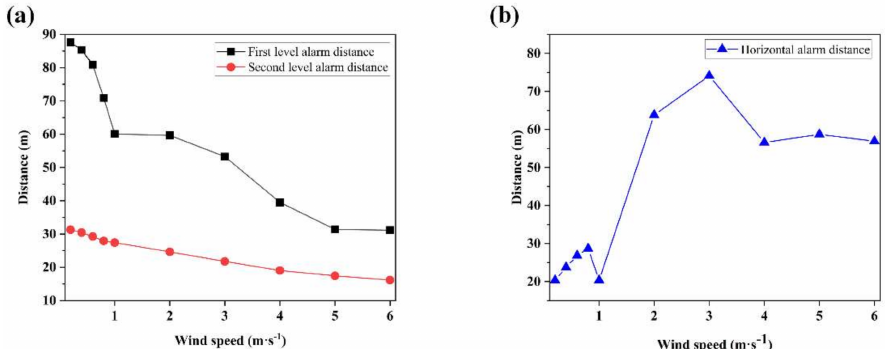
Figure 5. The relationship lines between the farthest alarm distance of combustible gas and wind speeds. ( a ) The relationship between the first-level and second-level alarm distance and the wind speed. ( b ) The relationship between the horizontal alarm distance and the wind